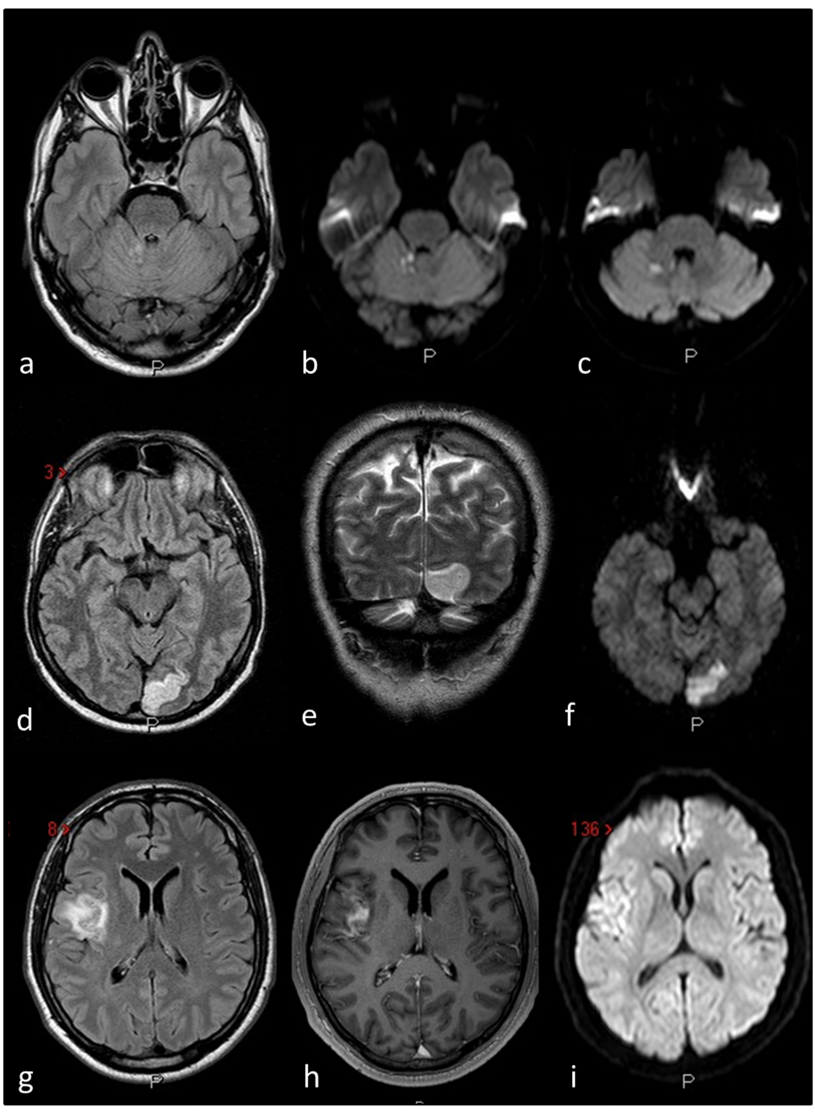
Figure 3. The figure outlines three examples of cryptogenic embolism in patients with PFO as imaged in Magnetic Resonance Imaging (MRI) of the brain: Patient 1 ( a – c ) multiple right cerebellar recent ischemic lesions on axial FLAIR ( a ) and DWI ( b , c ) MRI sequences. Patient 2 ( d – f ) left occipital ischemic stroke in a patient with migraine with aura and PFO on axial FLAIR ( d ) coronal T2W ( e ) and DWI MRI sequences. Patient 3 ( g – i ) right temporo-parietal ischemic stroke on axial FLAIR ( g ) contrast-enhanced axial T1W ( h ) and DWI ( i ) MRI sequences.